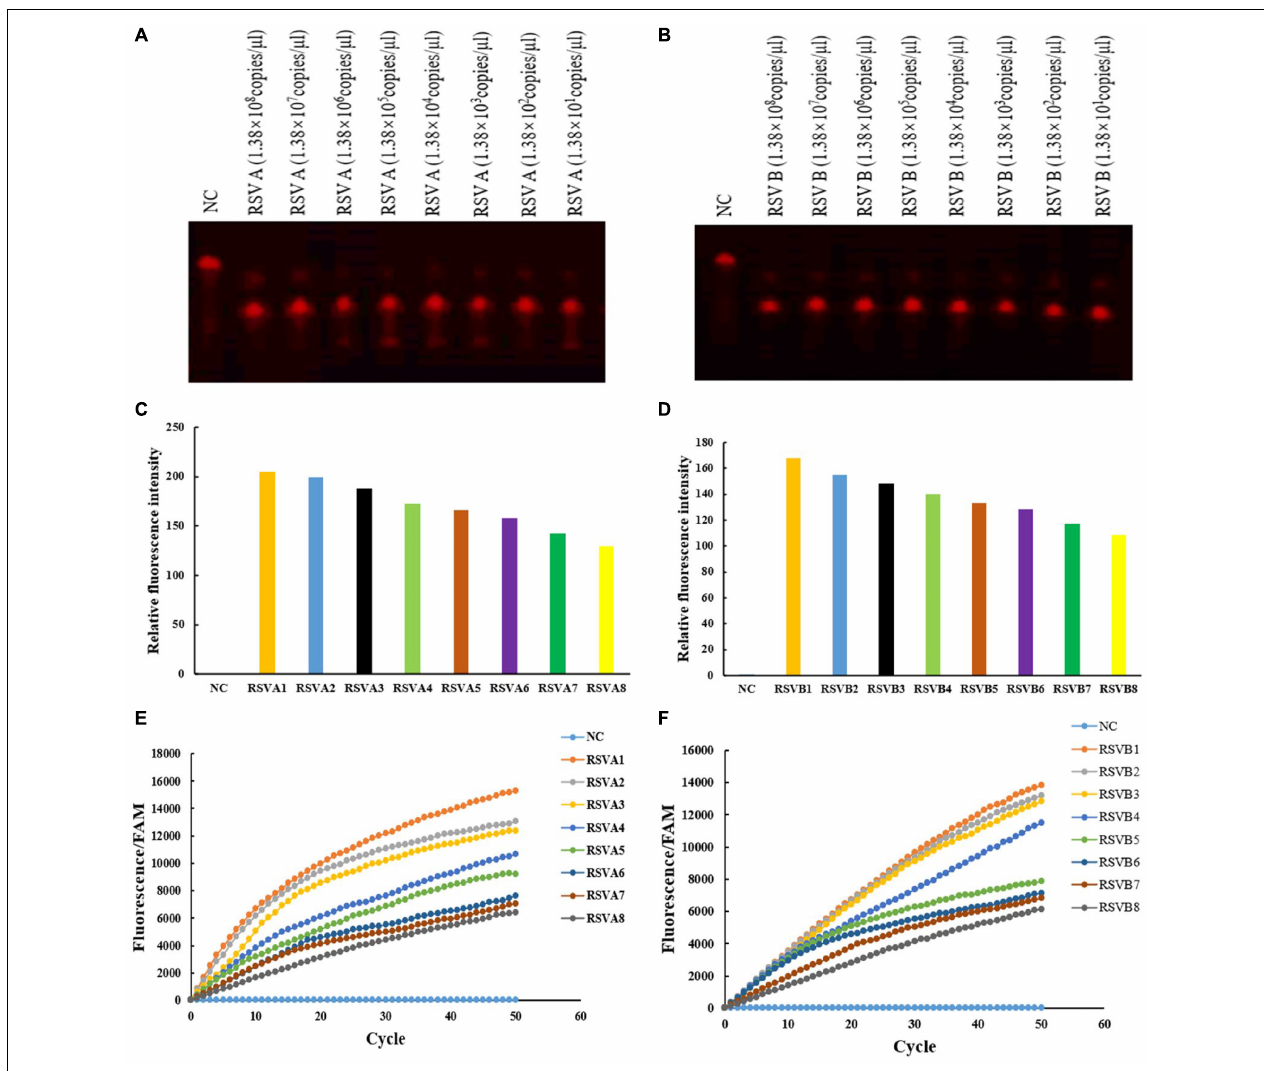
FIGURE 3 | crRNA activated Cas12a to cleave RSV A and RSV B RPA products and the fluorescence detection of the F-Q ssDNA reporter fragment. RSV A-TS2 activated Cas12a to cleave RSV A RPA products using different pUC57 plasmid concentrations (A) RSV B-TS4 activated Cas12a to cleave RSV B RPA products using different pUC57 plasmid concentrations (B) Fluorescence detection of RSV A and RSV B RPA products after Cas12a cleavage using a fluorescence multimode reader (C,D) and a real-time fluorescence PCR machine (E,F) RSV A1–RSV A8: 1.38 × 10 8 copies/ µ l–1.38 × 10 1 copies/ µ l, diluted 10-folds in ddH 2 O each time. RSV B1–RSV B8: 1.38 × 10 8 copies/ µ l–1.38 × 10 1 copies/ µ l, diluted 10-folds in ddH 2 O each time. NC: DNA-Cy5 and water (A,B) . NC: FAM and water (C–F) . All experiments were repeated three times ( n =